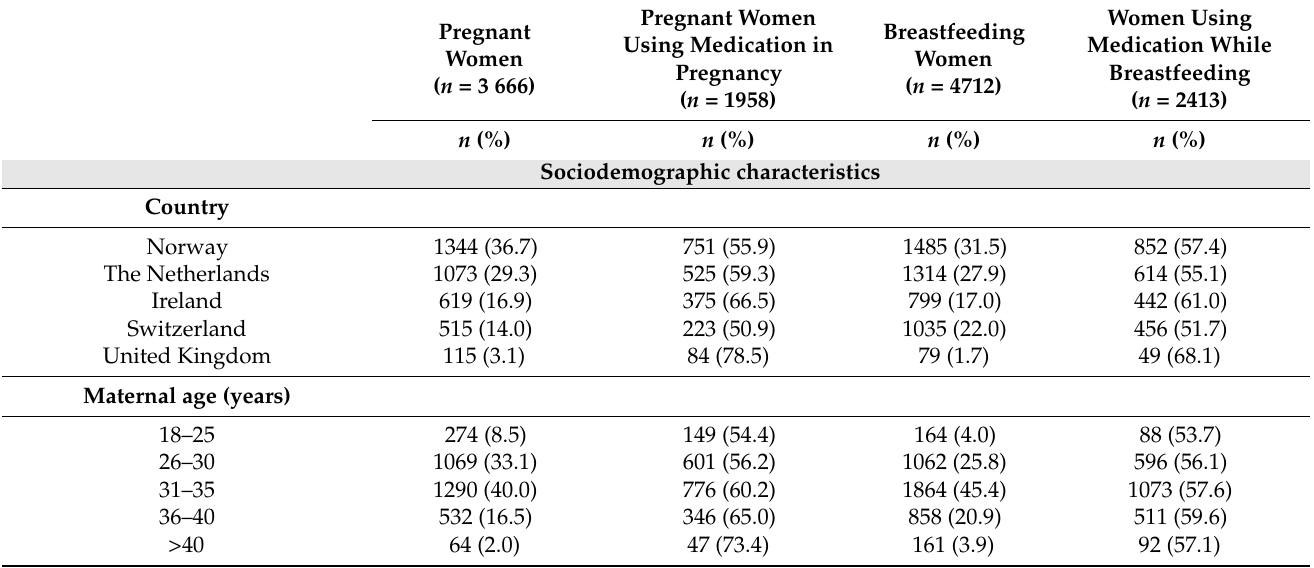
Table 1. Characteristics of participants according to any medication use in the preceding 3 months ( n =